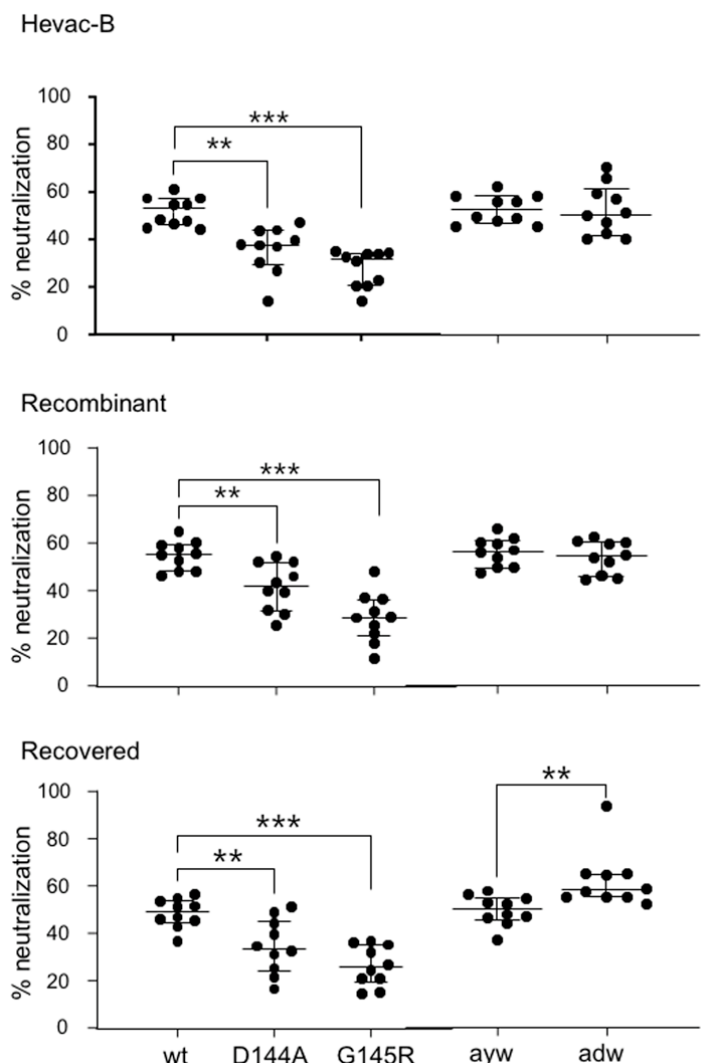
Figure 5. Anti-HBs antibodies are impaired in their capacity to neutralize HDV virions coated with envelope proteins of the main immune escape HBV variants D144A and G145. Antibodies from all groups could neutralize virions bearing envelope proteins of the adw and ayw subtypes. Each dot corresponds to an individual subject. Y-axis, percent neutralization. **, p -value < 0.01, ***, p -value < 0.001.